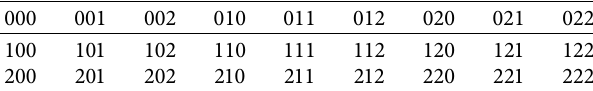
Figure 2: Two triple forms of vertex i in undirected graph. Table 1: Permutation and combination of 27